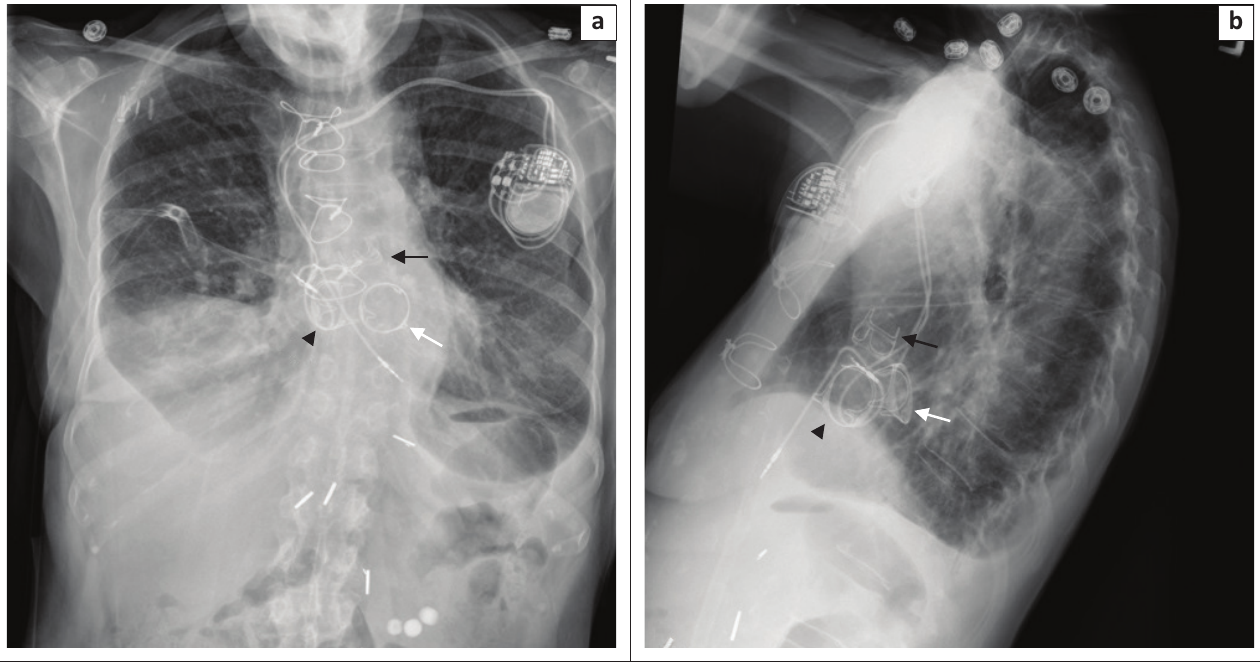
FIGURE 19: Frontal (a) and lateral (b) chest radiographs showing prosthetic aortic (black arrow), mitral (white arrow) and tricuspid (arrow head) valves in a 72-year-old female patient with a history of aortic and mitral stenosis, tricuspid regurgitation and complete heart